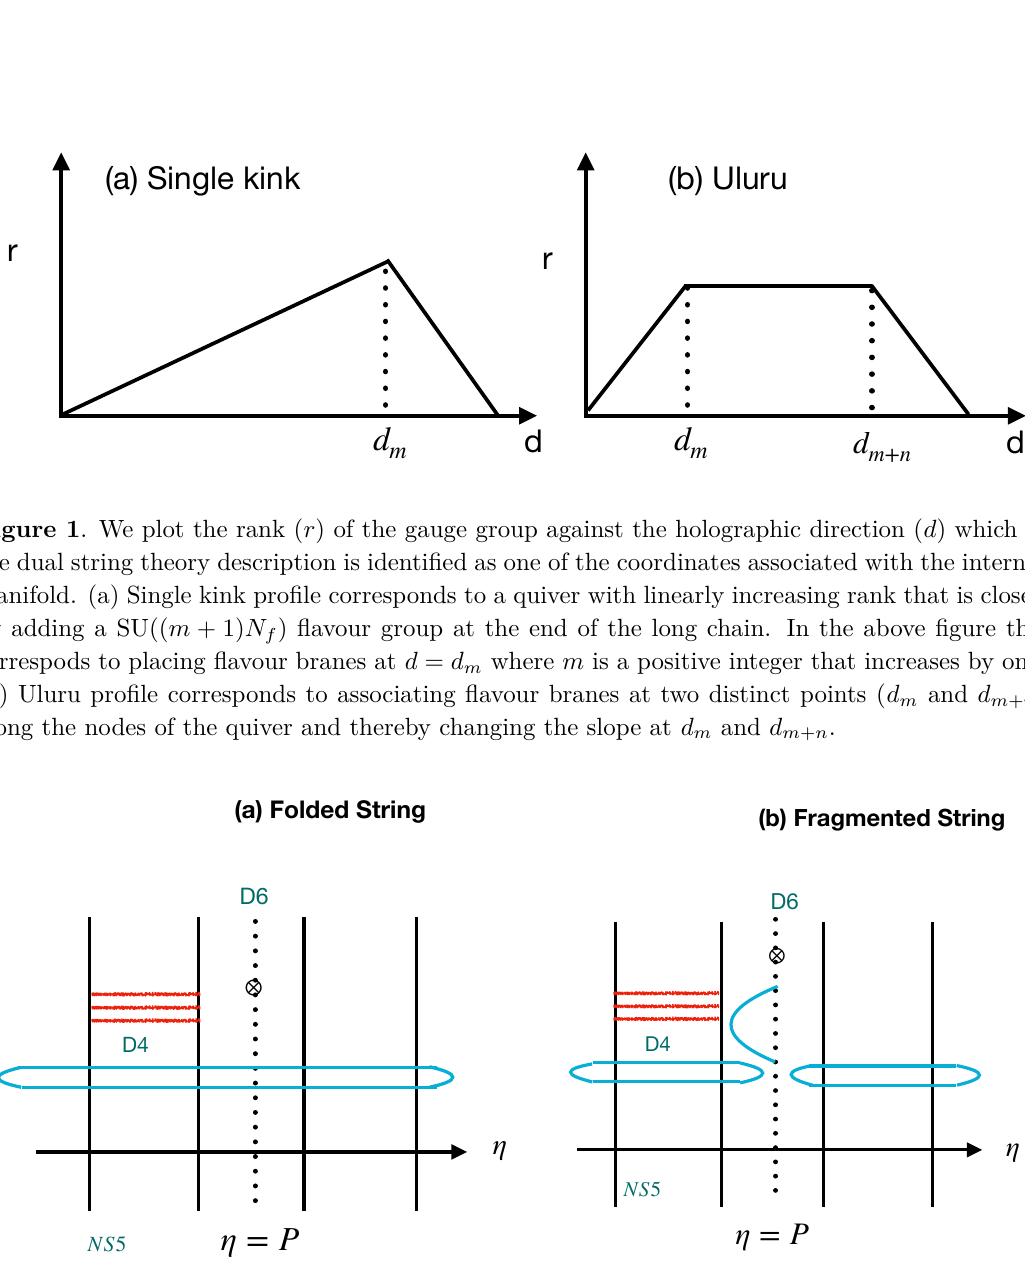
Figure 2 . (a) Long folded string passing through flavour D6 branes in a Hanany-Witten setup corresponding to N = 2 linear quivers, (b) Fragmented strings dual to N = 2 SCFTs in 4 d